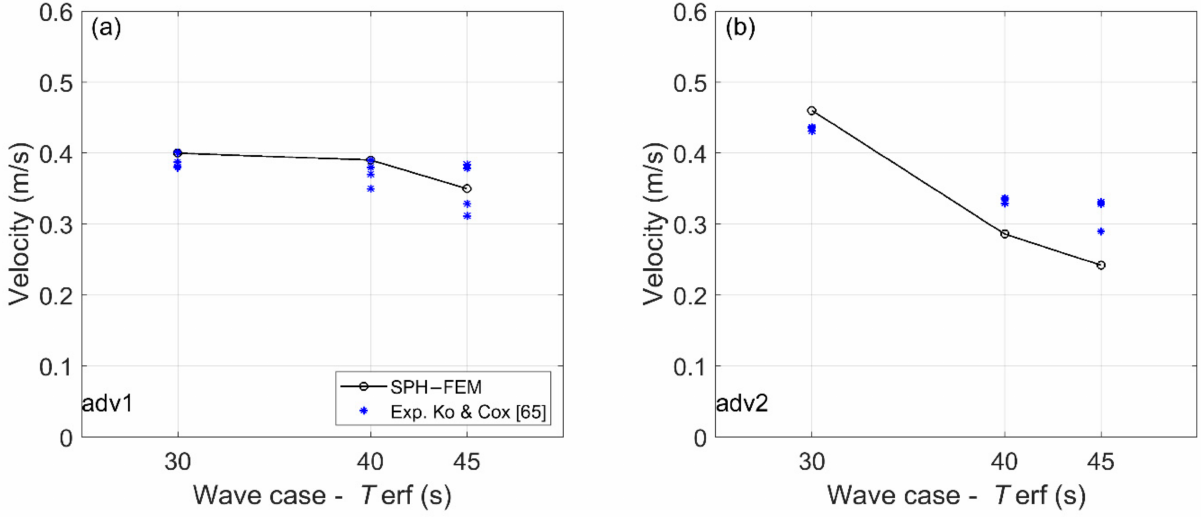
Figure 5. Maximum fluid velocities of experimental tests [65] and numerical simulations for h 1 = 2.496 m, and three wave cases with T erf = 30, 40, and 45